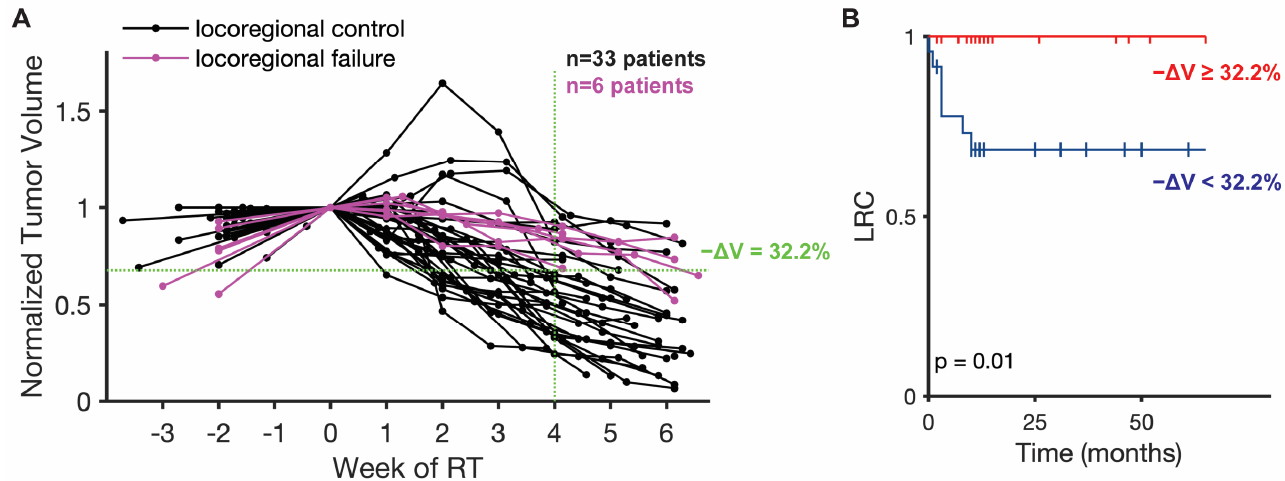
Figure 1. Patient tumor volume trajectories and correlation with locoregional control (LRC). ( A ) Longitudinal tumor volume trajectories for all 39 patients normalized by initial patient tumor volume at start of RT with one measurement before the start of RT and weekly measurements during the course of treatment. Patients with eventual locoregional failure are highlighted in purple. The indicated median volume reduction (−ΔV = 32.2%) at week 4 of RT perfectly separates the patients with locoregional control (LRC) and locoregional failure. ( B ) Kaplan–Meier survival plot for locoregional control (LRC) separated by percent tumor volume reduction (−ΔV = 32.2%) at 4 weeks of RT.